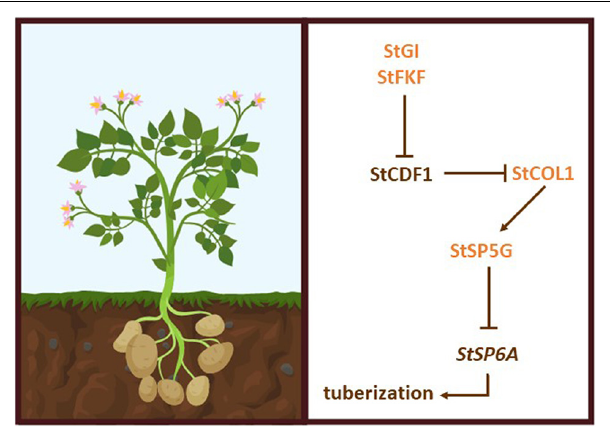
FIGURE 2 | Regulatory mechanism underlying tuber formation in potato. Right, components of the genetic pathway controlling tuberization. The tuberigen StSP6 is indirectly activated by StCDF1 and repressed by StCOL1 through